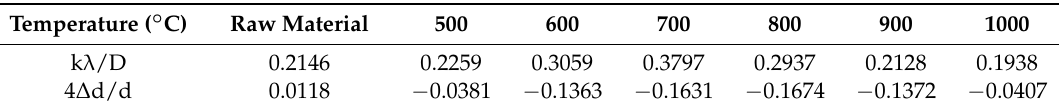
Figure 2. XRD patterns of sericite after heating at different temperatures. Table 2. Relation between Bcos θ and sin θ of sericite activated at different temperatures in the (002)